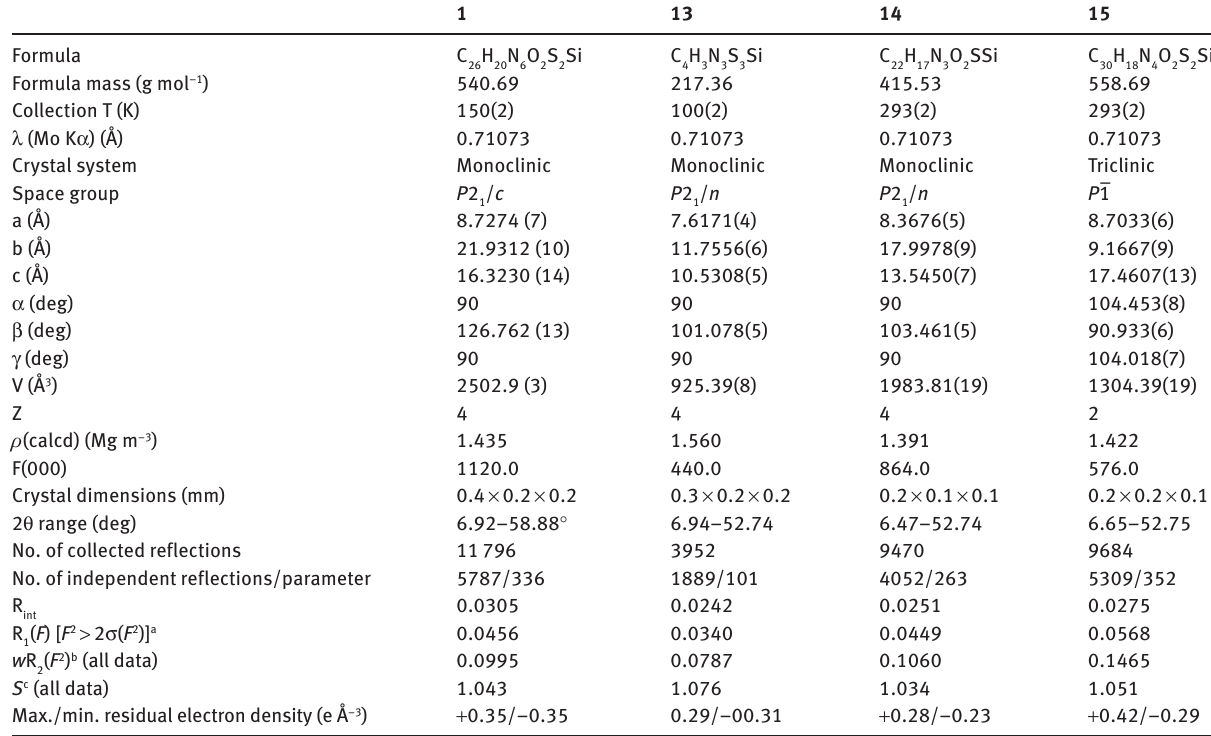
Table 2: Summary of the crystallographic data and structure refinement results for compounds 1 , 13–15 .